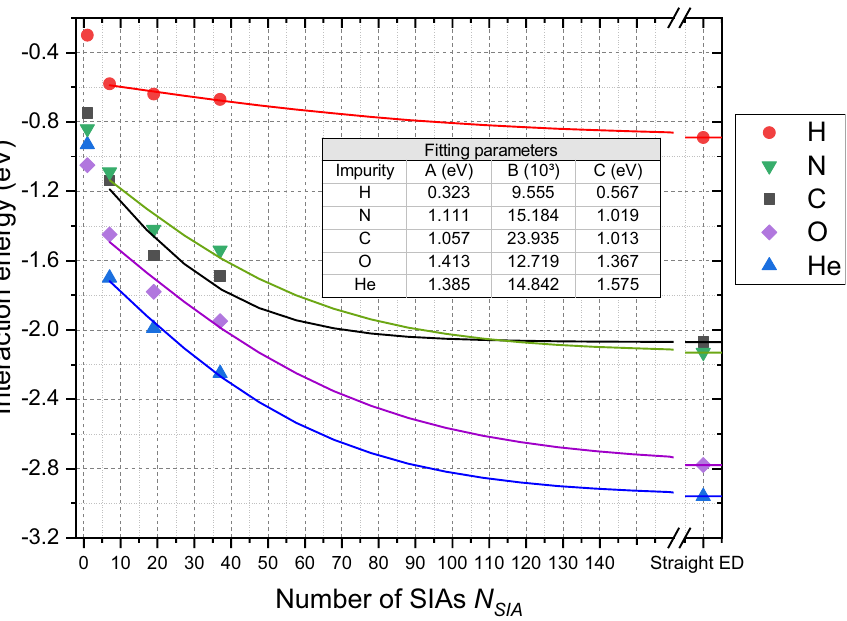
Figure 2. Interaction energy of interstitial impurities (H, N, C, O and He) with interstitial defects (single SIA, dislocation loops of various sizes (with 7, 19, 37 SIAs) and edge dislocation) in bcc W. The lines reproduce the resulting fitted curves for the interaction energy for each of the impurities. The inline table reports the fitting parameters for the fitted